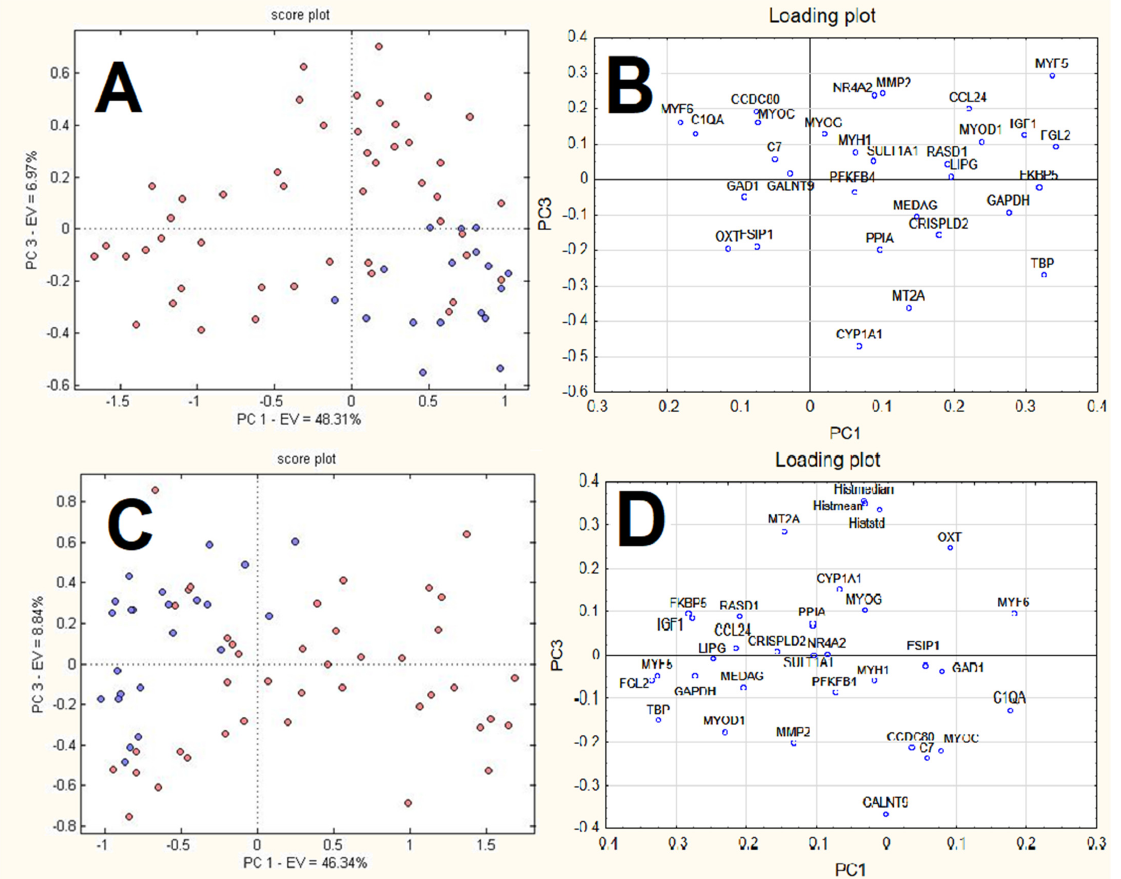
Figure 7. Results of PCA applied to the weights calculated for each neuron of the top map and each variable: score ( A ) and loading plot ( B ) for RQ dataset; score ( C ) and loading ( D ) for RQhisto dataset. The score plots report the neurons of the top map in different colours: blue circles correspond to neurons attributed to controls while red circles correspond to neurons attributed to dexamethasone- treated samples. For the RQhisto dataset (Figure 7C,D), control neurons have negative scores on PC1 and positive ones on PC3. These samples show high signals for variables MT2A, MYF5,